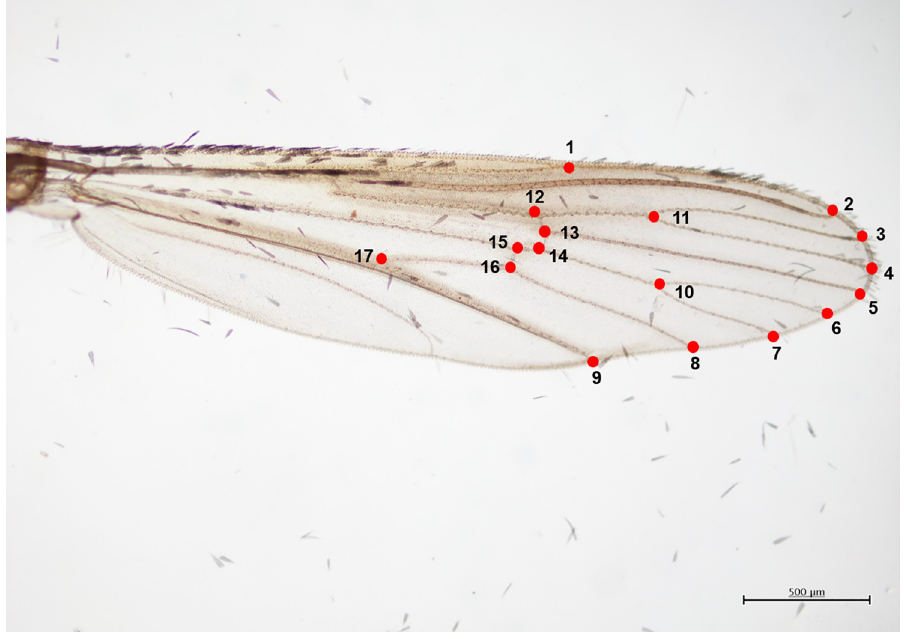
Fig 2. Representative image of wing landmark pattern. Right wing of female Ae . aegypti showing the 17 plotted landmarks based on Dujardin et al. (2017).